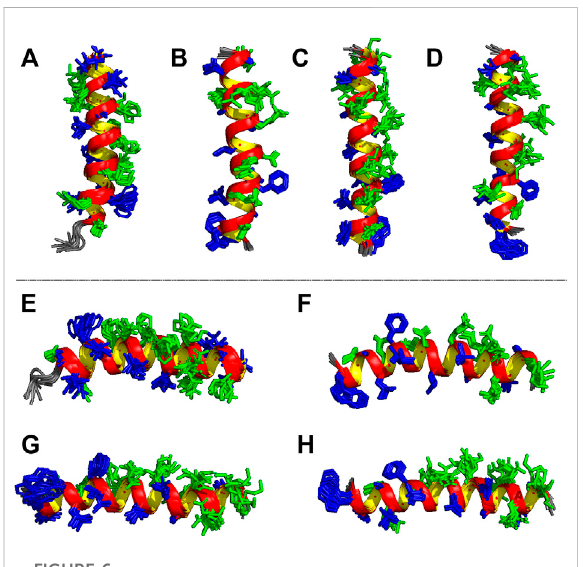
Ensembles of the 10 most stable structures of (A,E) LyeTx I (Santos et al., 2010, PDB ID 7MMM), (B,F) LyeTx I-b (Reis et al., 2018, PDB ID 6CL3), (C,G) LyeTx I-b cys and (D,H) LyeTx I-bPEG. Panels (A – D) show the vertical perspective of each helical structure with each respective N -terminus facing down while panels (E – H) represent the horizontal view with each N -terminus to the left and C -terminus to right. Hydrophobic residues are shown in dark blue and hydrophilic residues in